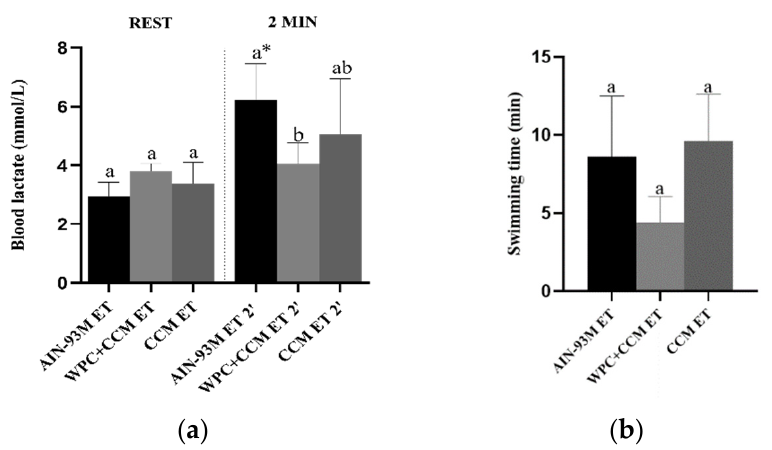
Figure 7. Blood lactate levels and swimming time. ( a ) Blood lactate levels collected at resting and 2 min after performing the exhaustive swimming test. ( b ) Swimming time. AIN-93M: group not submitted to ET that received a standard diet; AIN-93M ET: group submitted to the exhaustion test